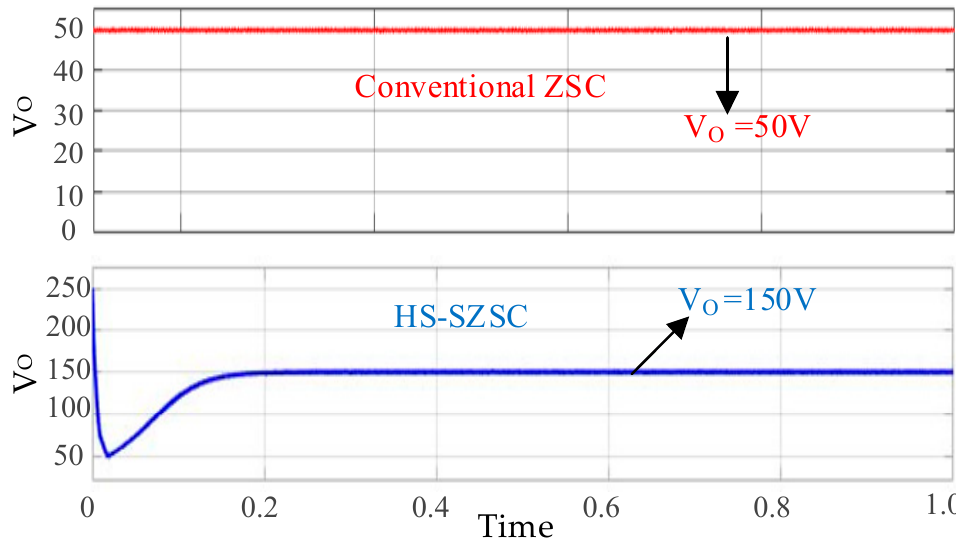
Figure 9. The output voltage waveforms for the ZSC and HS-SZSC.